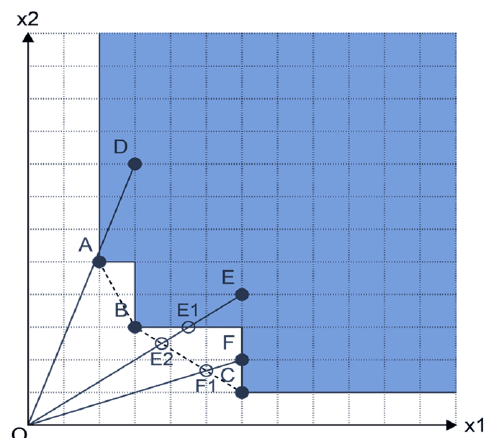
Figure 2. Relationship between the CRS, VRS and FDH models. Reprinted from Ref. [74]. The FDH model provides the free impossibility of creating the production possibility set. Therefore, the frontier line for the FDH is established based on the detected inputs and outputs. Figure 3 shows the production possibility set in FDH. There are two inputs and one output for six DMUs, categorised A to F. Based on the suggested evaluation, the efficiency score of the FDH model is between 0 and 1. Therefore, in the input-oriented approach, the efficiency for the FDH input-oriented model is permanently more than the input-oriented VRS and CRS models.